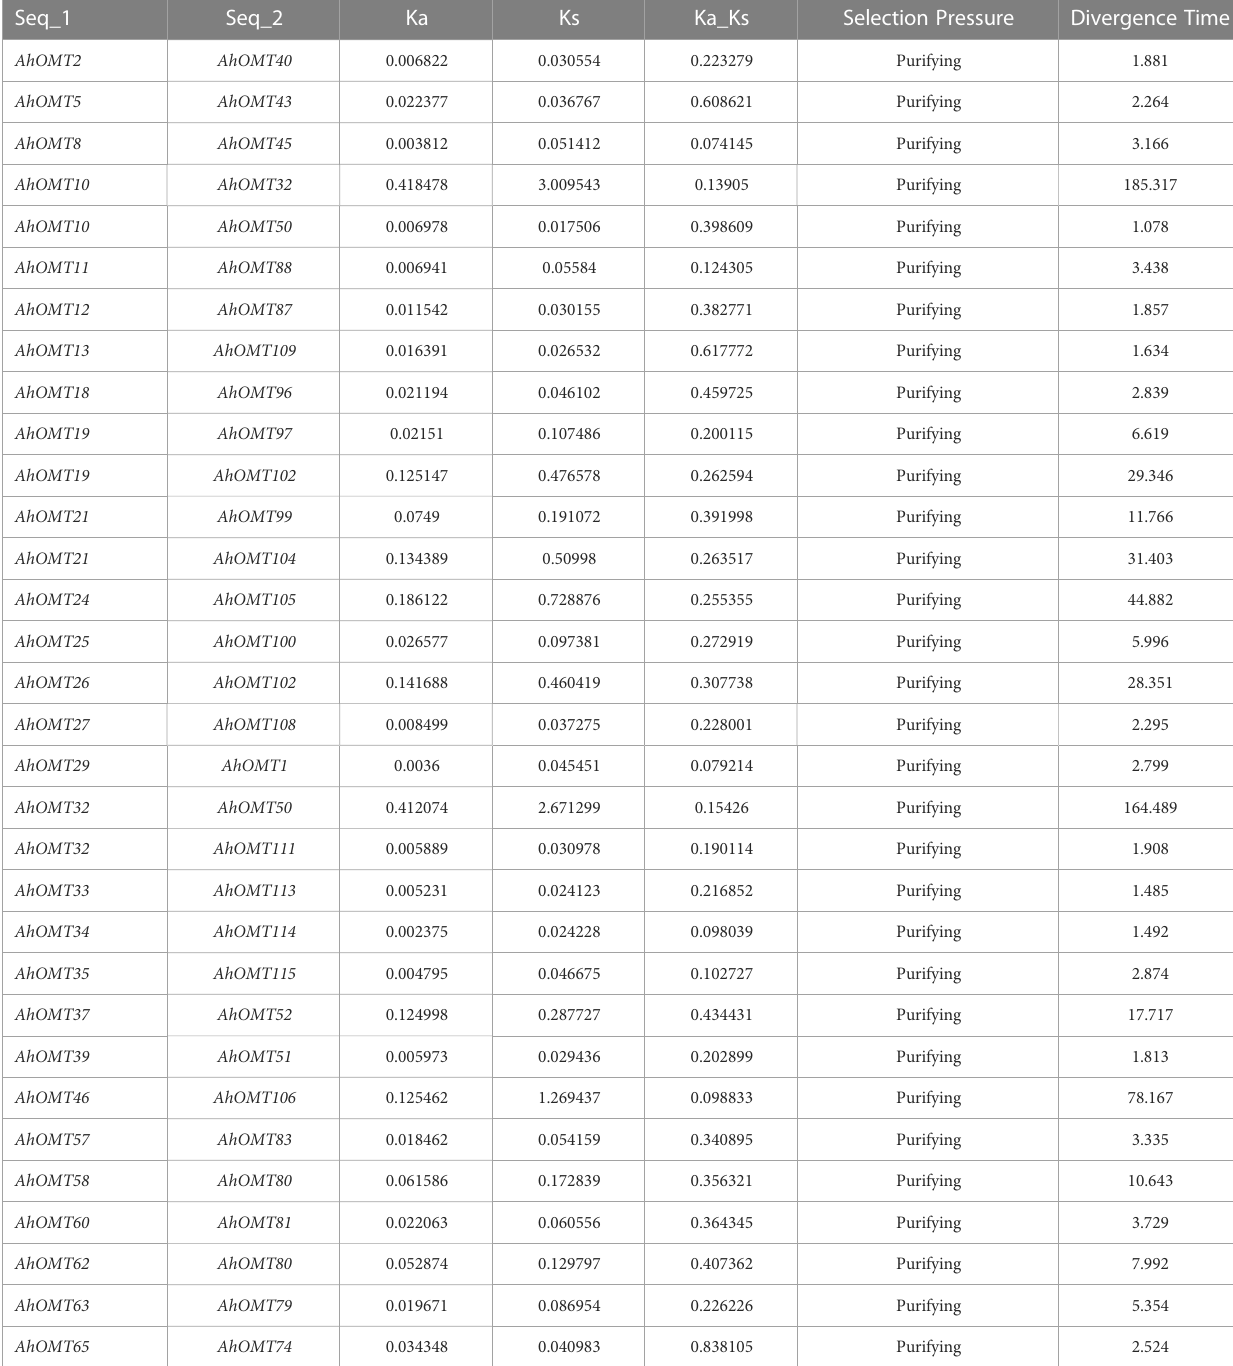
TABLE 2 Calculation of Ka/Ks values and divergence time of duplicated